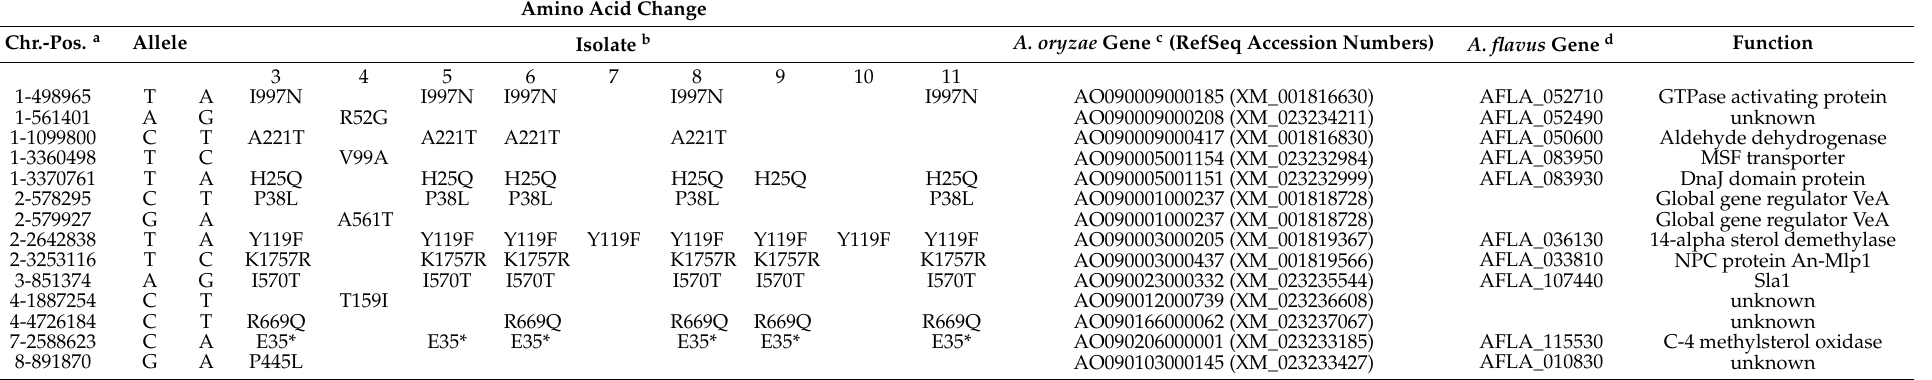
Table 2. Nonsynonymous mutations in azole-resistant A. flavus isolates compared to two isogenic azole-susceptible isolates. Amino Acid